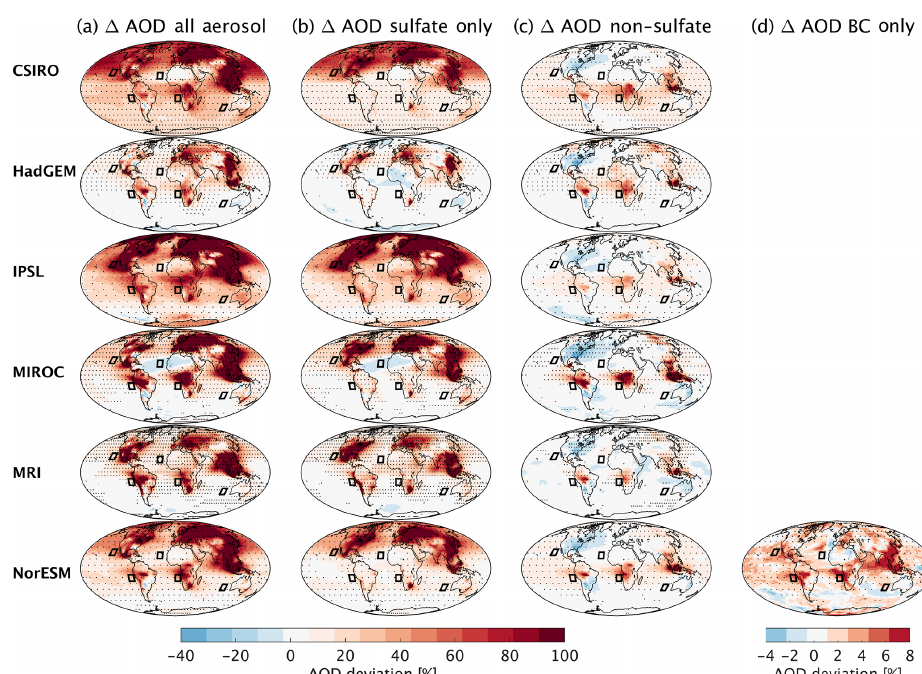
Figure 1. Relative AOD deviation in percent between (a) the all-aerosol and control experiments, (b) the sulfate-only and control experiments, (c) the all-aerosol and sulfate-only experiments for six CMIP5 models, and (d) the BC-only and control experiments for one model. Statistical significance at the 5% level, determined with a t test, is indicated with stippling, interpolated to a coarser grid. Black boxes indicate the five analysis regions of marine stratocumulus